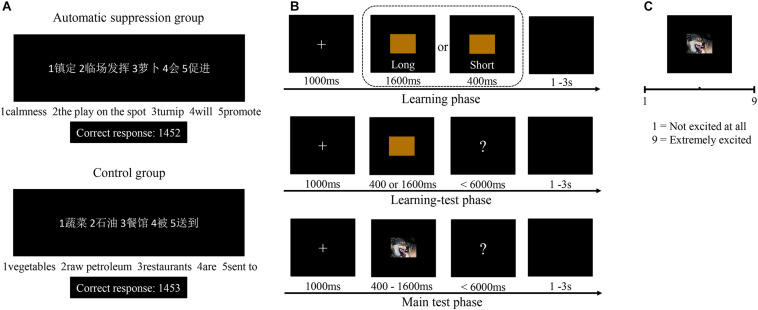
The procedure of Experiment 2. (A) Schematic illustration of the sentence-unscrambling task for the automatic suppression group and control group. Each sentence unscrambling task contains five Chinese words. (B) Schematic illustration of the temporal bisection task. (C) Schematic illustration of the arousal assessment.